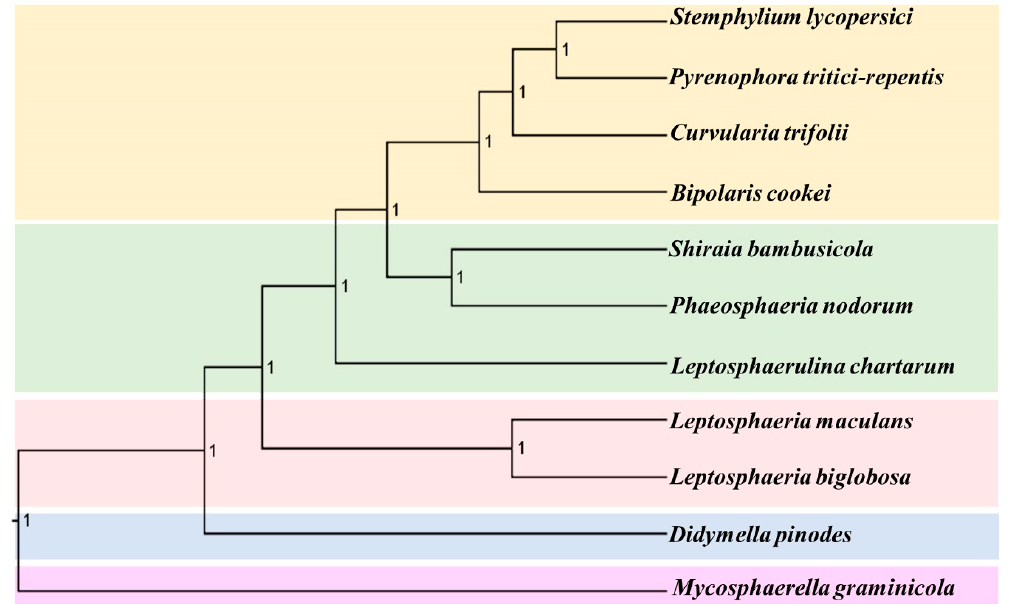
Figure 7. Phylogenetic analyses for combined mitochondrial DNA datasets. A combined dataset consisting of the 12 common protein-coding genes ( atp6 , cob , cox1 , cox2 , cox3 , nad1 , nad2 , nad3 , nad4 , nad4L , nad5 , and nad6 ) that are encoded in C. trifolii and L. chartarum and other related mitochondrial genomes was used to construct this phylogenetic tree.